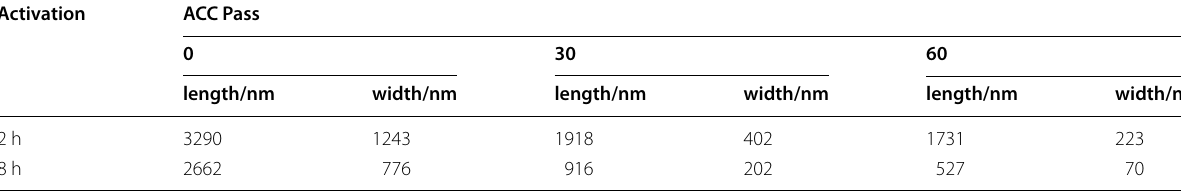
Table 2 Averaged lengths and widths of the aqueous counter collision (ACC)-treated activated carbon particles